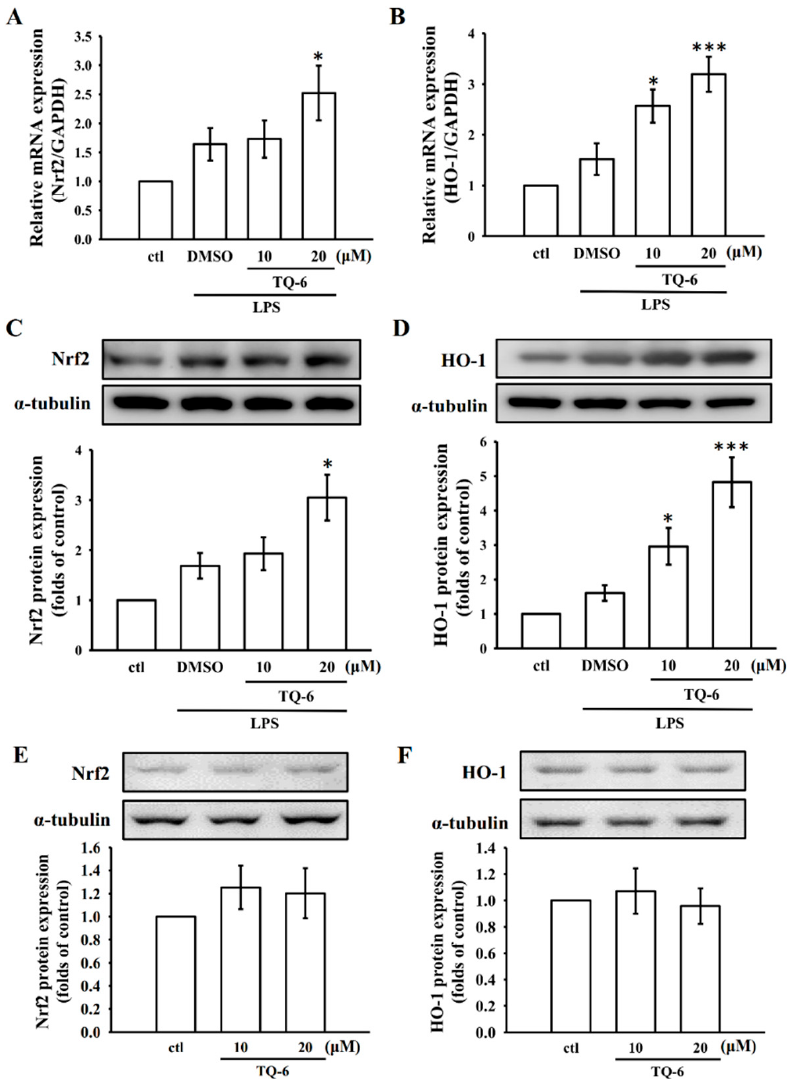
Figure 4. Effect of TQ-6 on Nrf2/HO-1 in LPS-stimulated RAW 264.7 cells. In TQ-6-treated cells followed with LPS exposure, the mRNA expression levels of ( A ) Nrf2 and ( B ) HO-1 were evaluated by RT-qPCR. The protein expression of ( C ) Nrf2 and ( D ) HO-1 was determined by immunoblotting. ( E , F ) Cells were treated with TQ-6 (10 and 20 µ M) alone for 20 min, ( E ) Nrf2 and ( F ) HO-1 protein expression were determined by immunoblotting. Results are given as the means ± SEM ( n = 4) and measured by the Biolight Windows Application, V2000.01 (Bio-Profil, Vilber Lourmat, France). * p < 0.05 and *** p < 0.001 compared with the LPS group.